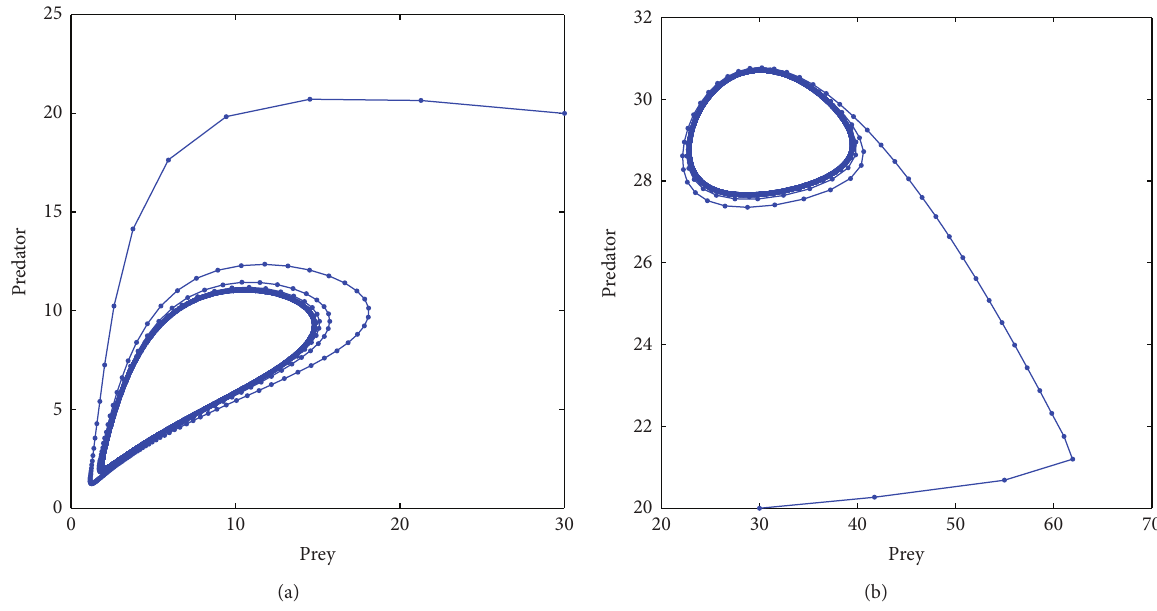
Figure 5: The phase portrait of system (24) by using the initial conditions 𝑥 0 = 30, 𝑦 0 = 20 . There is a periodic solution when the prey obeys the Allee effect which gets to a large value. Parameter values: (a) 𝑟 = 0.7 , 𝛼 = 0.03 , 𝛽 = 0.1 , 𝐾 = 100 , and 𝑢 2 = 18 ; (b) 𝑟 = 3 , 𝛼 = 0.04 , = 23 . 𝛽 = 0.04 , 𝐾 = 100 , and 𝑢 2